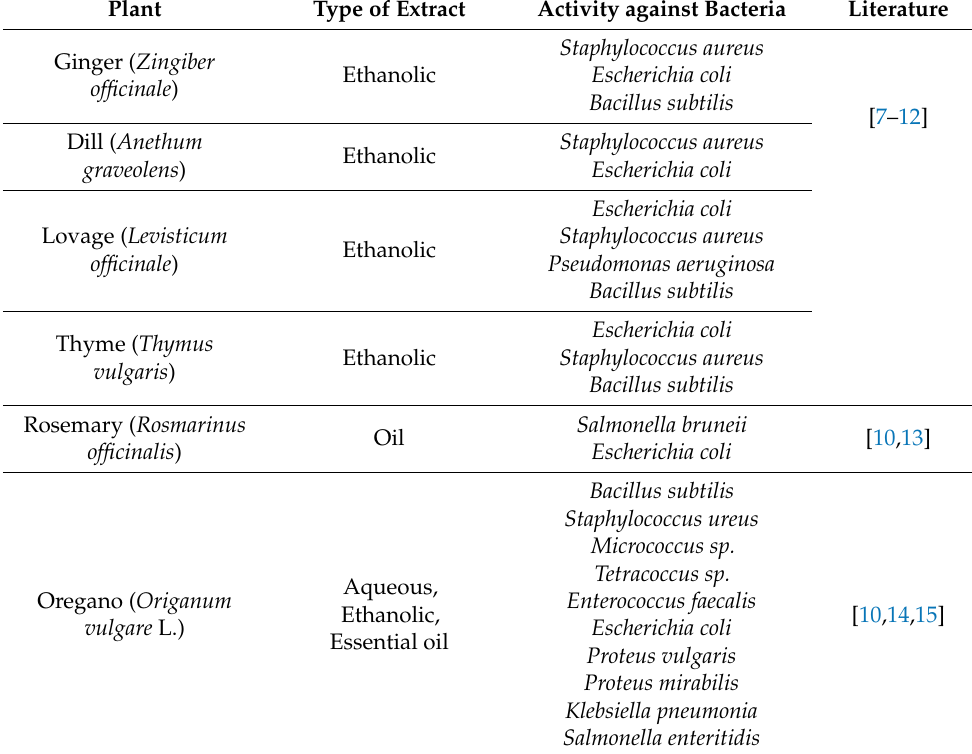
Table 1. Examples of plants extracts and their activity. Plant Type of